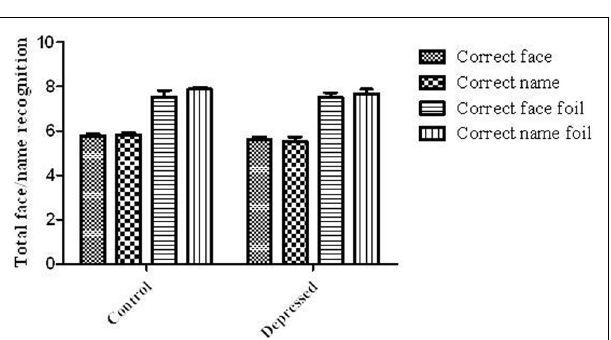
FIGURE 4 | Recognition of faces and names. There was no significant difference between the two groups for lures and foils for both the faces and names. Error bars represent